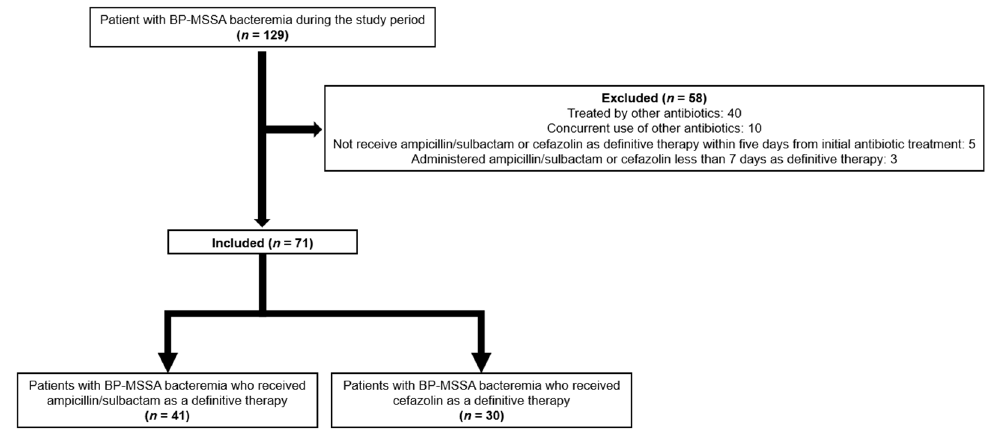
Figure 1. Flowchart of the inclusion and exclusion of β -lactamase-producing methicillin-susceptible S. aureus bacteremia cases in the study cohort. Patients were excluded if they met the following conditions: (1) concurrent use of other antibiotics, (2) non-administration of SAM or CFZ as definitive therapy within 5 days from initiation of the initial antibiotic treatment, and (3) administration of SAM or CFZ for less than 7 days as definitive therapy. BP-MSSA; β -lactamase-producing methicillin-sensitive S. aureus .